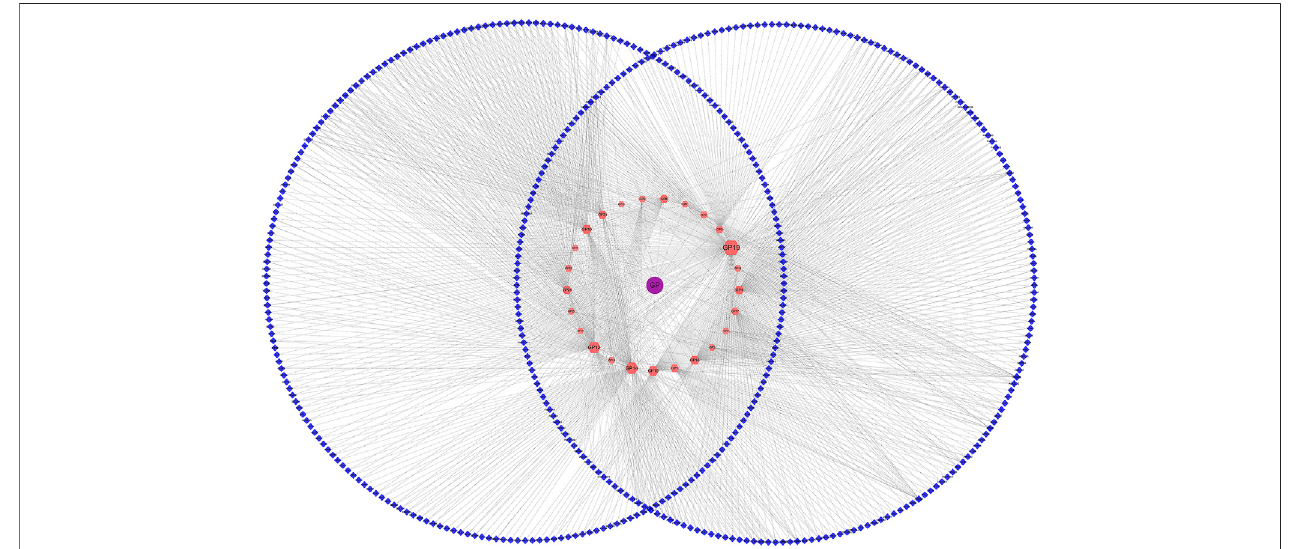
FIGURE 3 | Compound – compound target network (blue nodes: predicted targets, red nodes: compound of Gynura procumbens , and purple nodes: drug of Gynura procumbens (GP)).